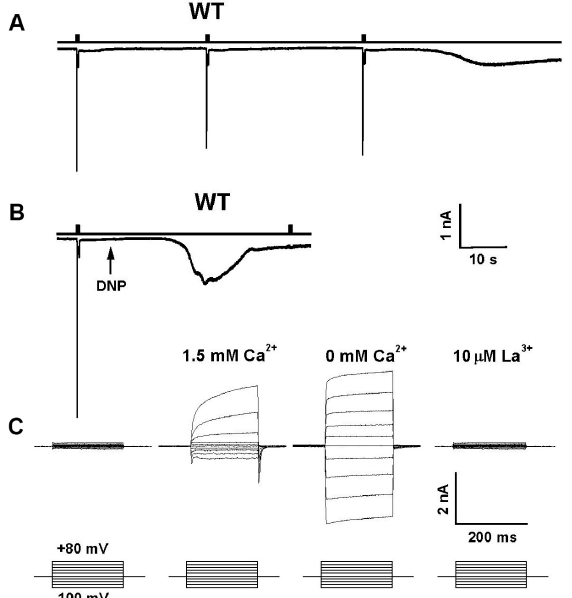
Figure 3. Depletion of cellular ATP activated the TRP channels: Membrane currents are usually elicited by light in the present of ATP and NAD in the pipette. Omission of these agents, combined with either few light pulses or with application of DNP to the bath induced constitutive activation of the light sensitive channels as monitored by a sustained noisy inward current that had the characteristics of the TRP or TRPL-dependent current. None of these currents were observed in the double null mutant trpl;trp P343 . ( A ) The typical light induced current (LIC) of a wild type (WT) cell in response to orange lights (Schott OG 590, attenuated by 1 log unit) in the absence of ATP and NAD in the pipette. Note that after 3 light-pulses the TRP channels open spontaneously (right). The light monitor is indicated above the measured current traces. ( B ) Membrane currents were recorded 30 s after establishing the whole-cell configuration with physiological concentrations (1.5 mM) of Ca 2+ in the bath. Whole cell recordings were conducted with pipettes, in which ATP and NAD were omitted and DNP was applied to the external medium at a time indicated by an arrow. Note the LIC was elicited by a light-pulse and the continuous opening of the channels in the dark following application of DNP. Also note that an additional light stimulus during the dark current elicited no response. ( C ): Families of current traces elicited by series of voltage steps from photoreceptors of wild type before (left traces) and following application of DNP (all other traces) in the presence of 1.5 mM Ca 2+ in the bath (second family traces), with ~0 (nominal) mM Ca 2+ in the bath (third family traces) and when 10 µ M La 3+ was applied to the bath (fourth family traces). For each experiment, a series of nine voltage steps was applied from a holding potential of − 20 mV in 20 mV steps (bottom traces). (From [68], Copyright 2000 Society for